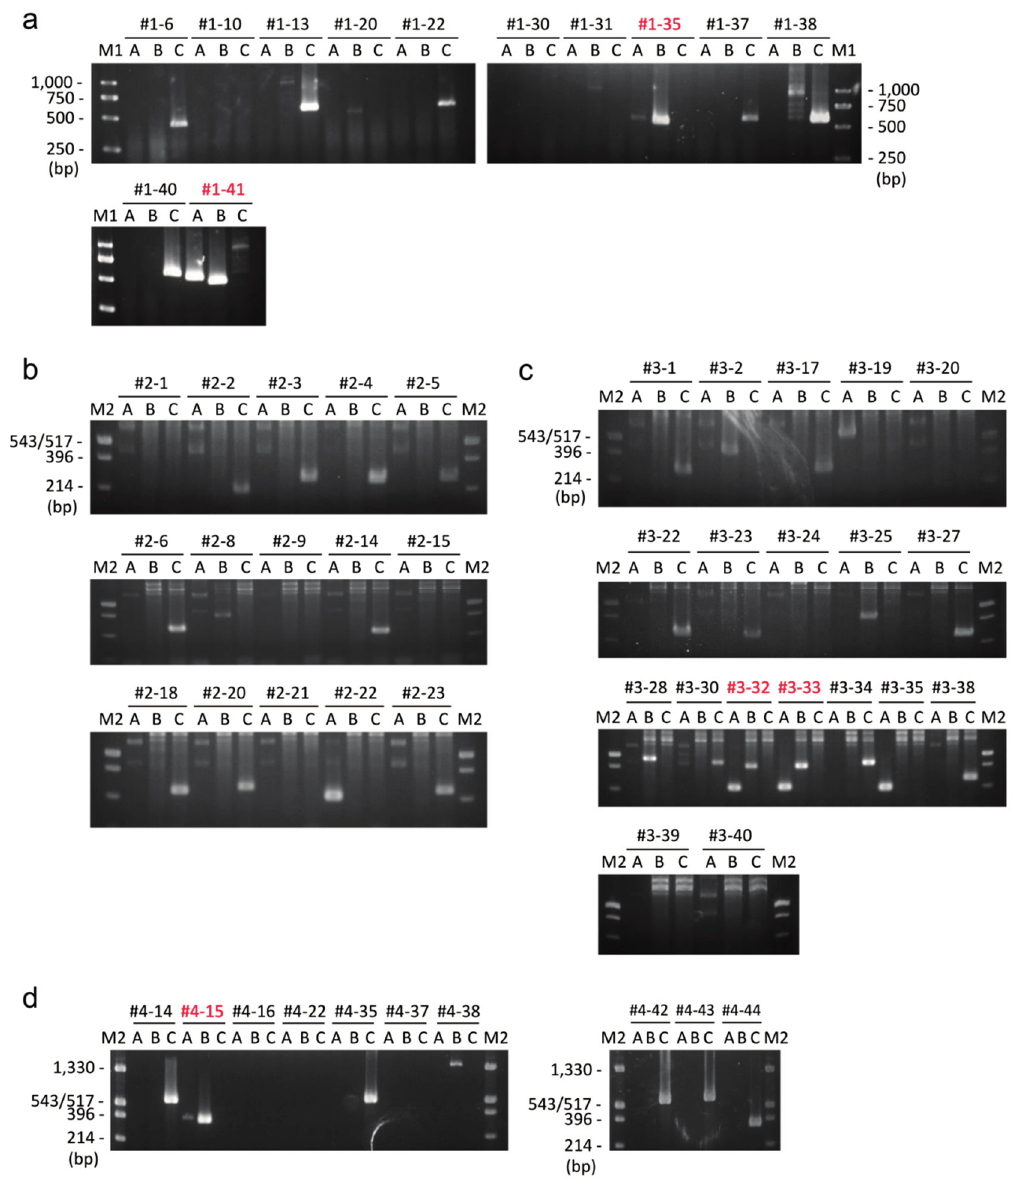
Figure 3. PCR genotyping. The results were shown separately for whole plasmid knock-in without carrying an scFv-Fc cassette ( a ), whole plasmid knock-in carrying an scFv-Fc cassette with puromycin selection from 72 h post-transfection ( b ) or from 24 h post-transfection ( c ), and backbone-free knock-in ( d ). The clone IDs are shown at the top of each panel. Red letters indicate correctly knocked-in clones. A, B, and C indicate the PCR products of 5 ′ junction, 3 ′ junction, and non-knock-in allele, respectively. M1, Wide-Range DNA Ladder (100–2000 bp) (TAKARA BIO INC.). M2,